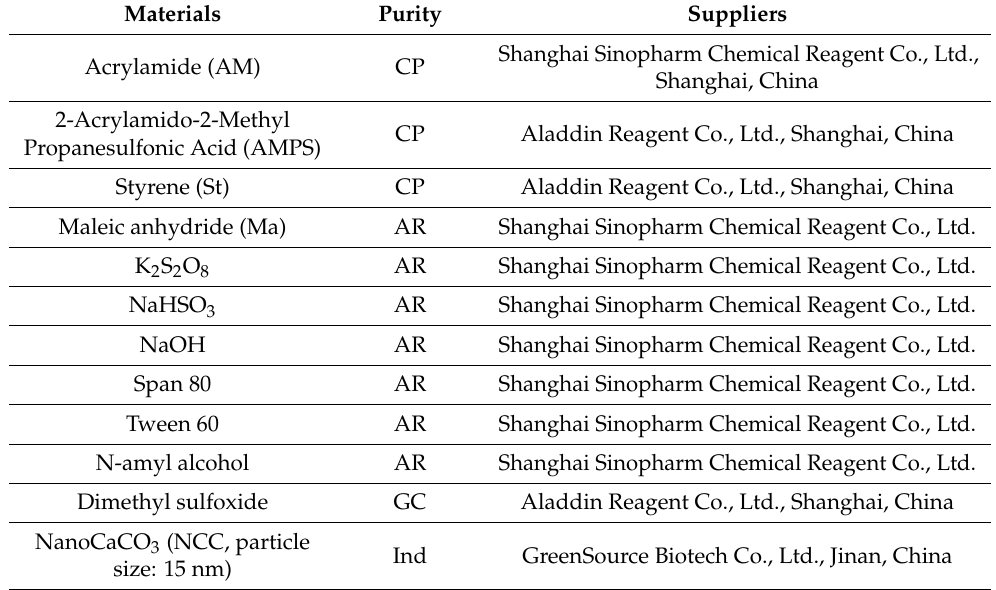
Table 1. Major Materials for Synthesis of PAASM-CaCO 3